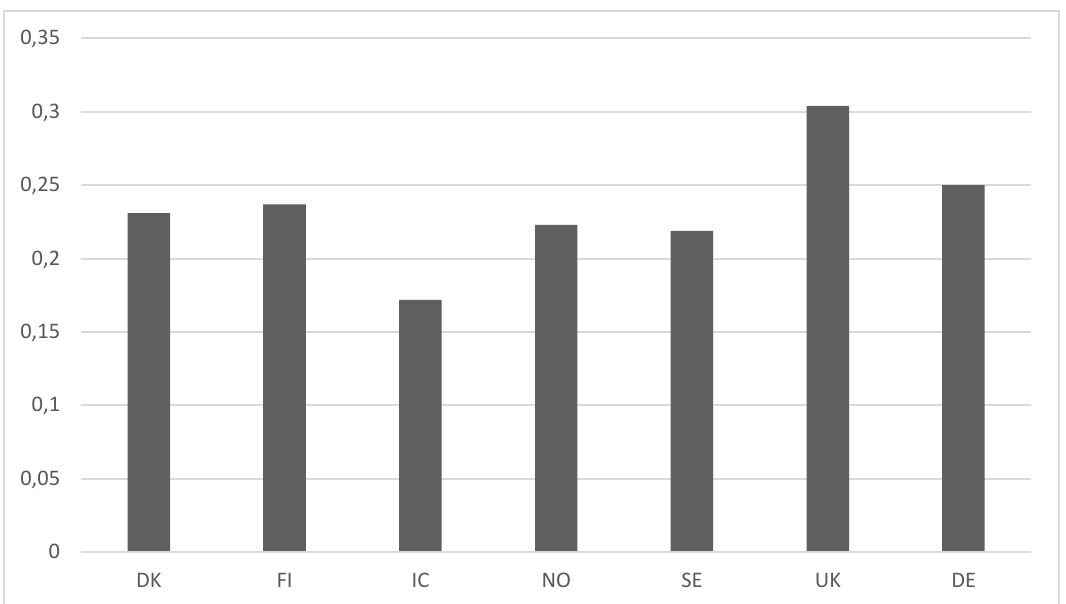
Figure 5: Income inequality as measured by the Gini coefficient. Based on equivalized household income in the Nordic countries, UK and Germany, 2012